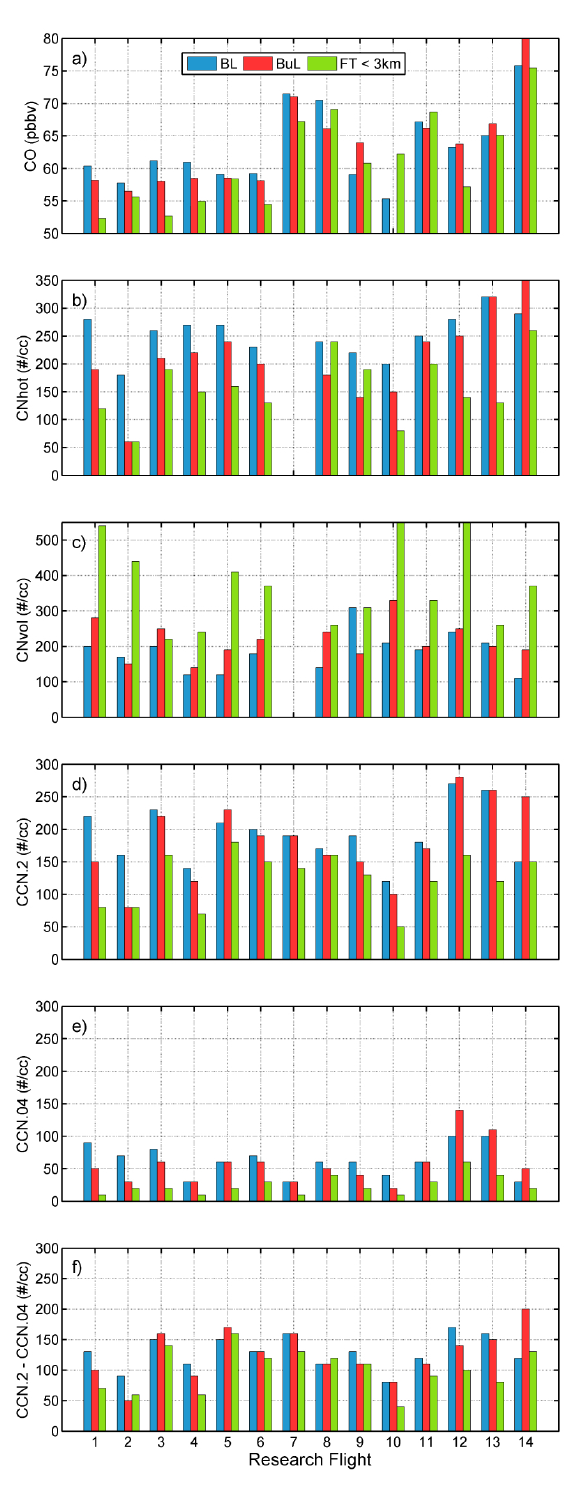
Fig. 11. Mean values over each flight for indicated PASE measure- ments in the surface mixed layer (BL), buffer layer (BuL) and in the FT < 3km. See text for details.